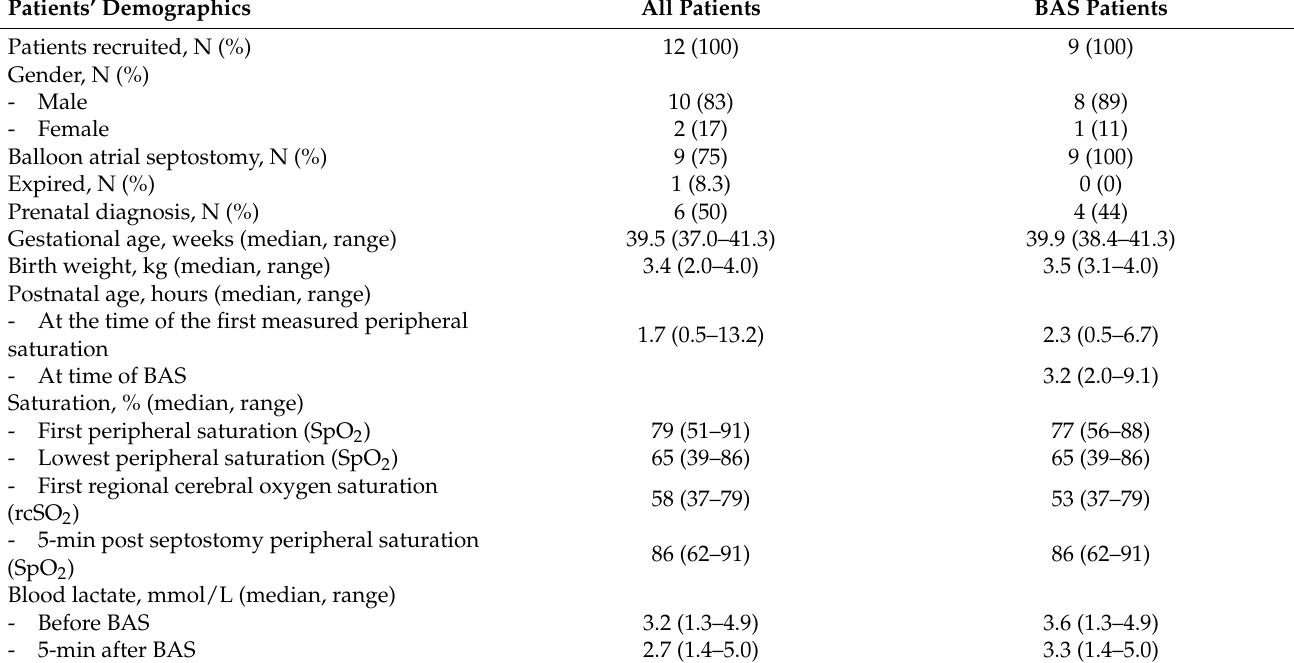
Table 2. Patients’ demographics and timing of postnatal clinical and analytical